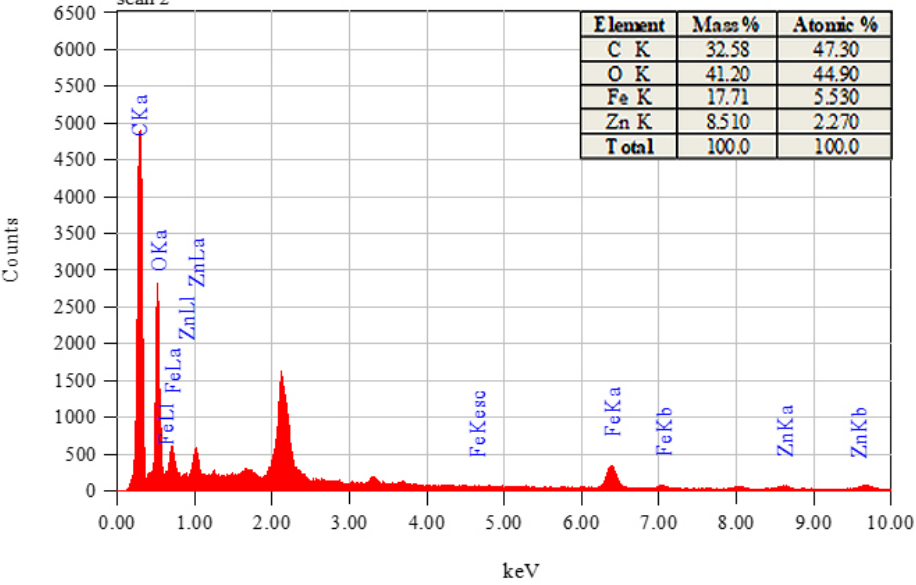
Figure 3. EDS spectra along with elemental composition.